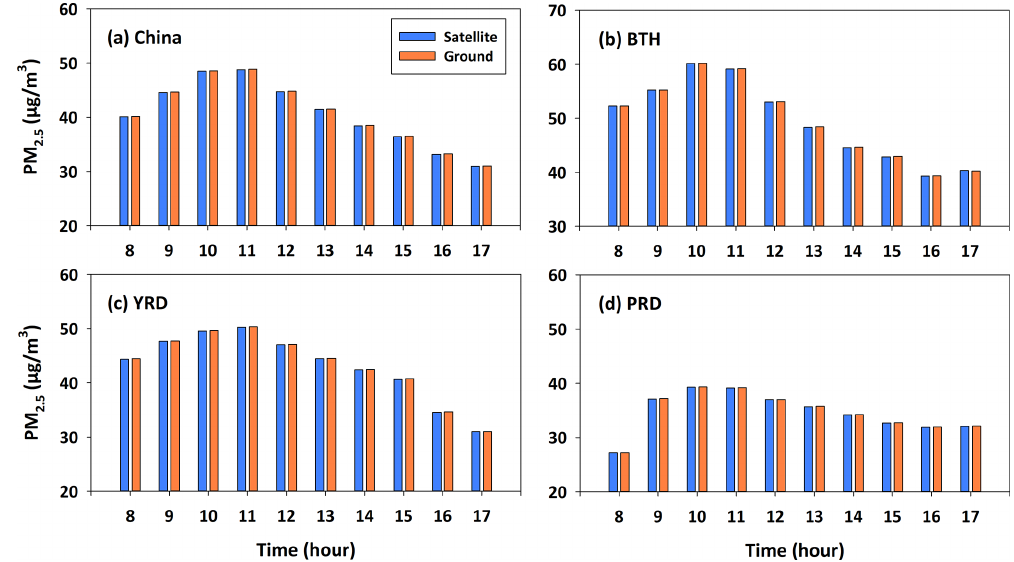
Figure 9. Time series of Himawari-8-derived (blue bars) and ground-based (orange bars) PM 2 . 5 diurnal variations (µgm − 3 ) in (a) China,